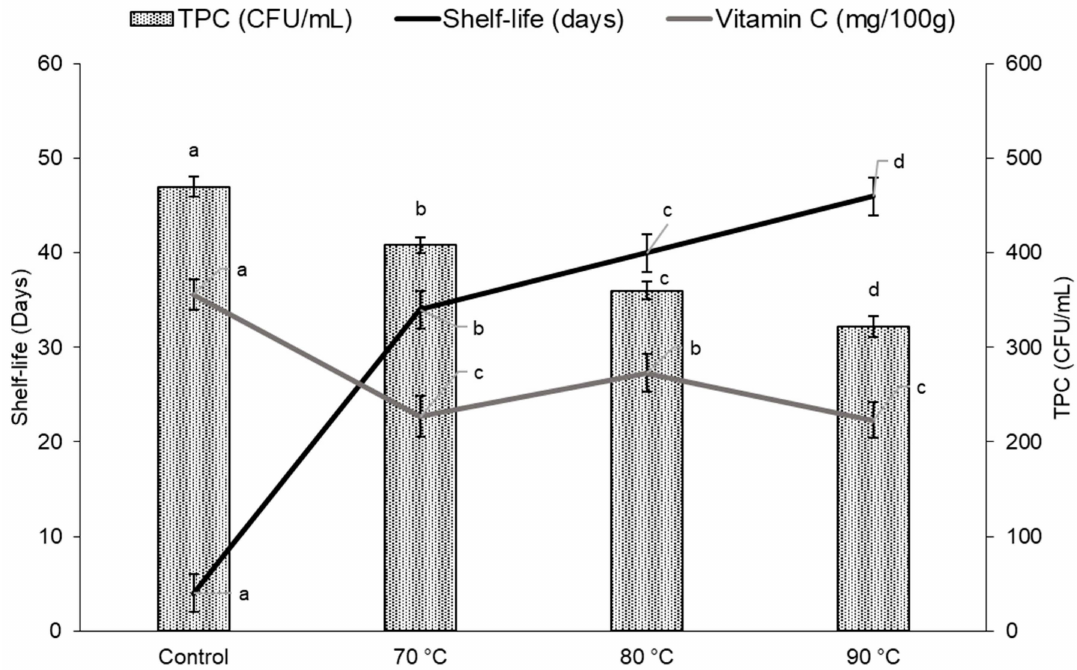
Figure 6. TPC and shelf-life of tomato-based pineapple beverage samples thermally treated at 70, 80, and 90 ◦ C. Different lower-case alphabets represents significant difference in the values for samples untreated and treated at different